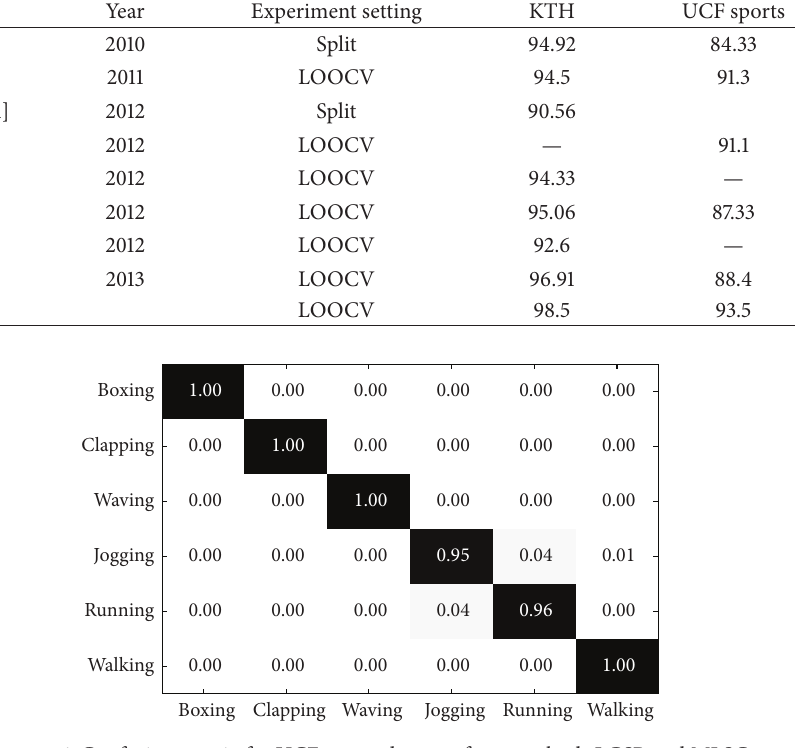
Figure 6: Confusion matrix for UCF sports dataset of our methods LGSR and MLSC.